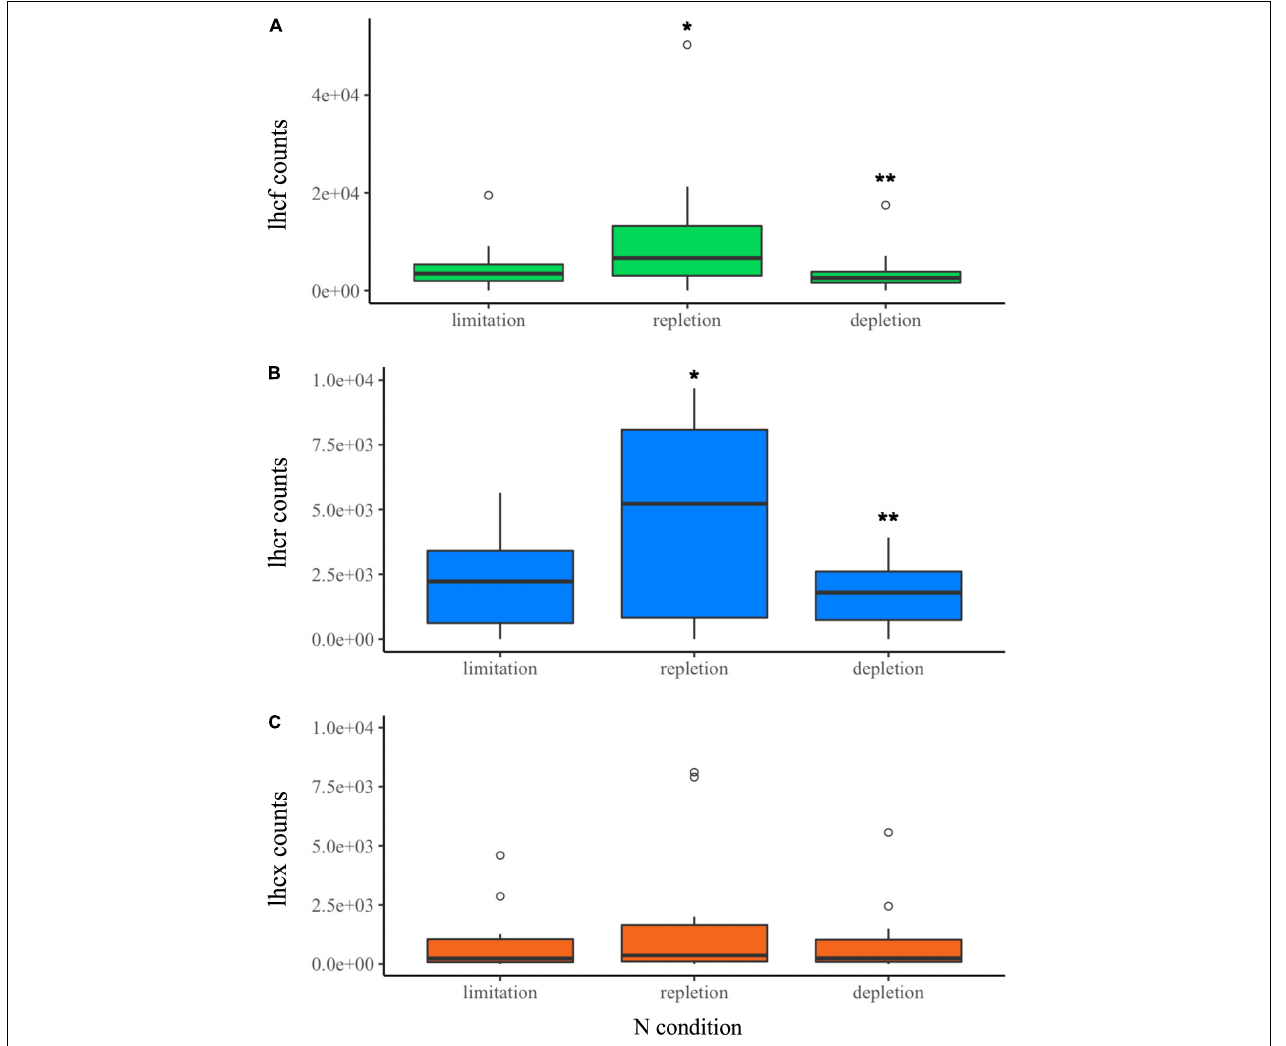
FIGURE 5 | CL experiment. Normalized transcript counts of (A) lhcf (green), (B) lhcr (blue), (C) lhcx (orange) genes according to N status (limitation, repletion, and depletion). Analysis of variance (ANOVA) test: * p -value < 0.05, ** p -value <